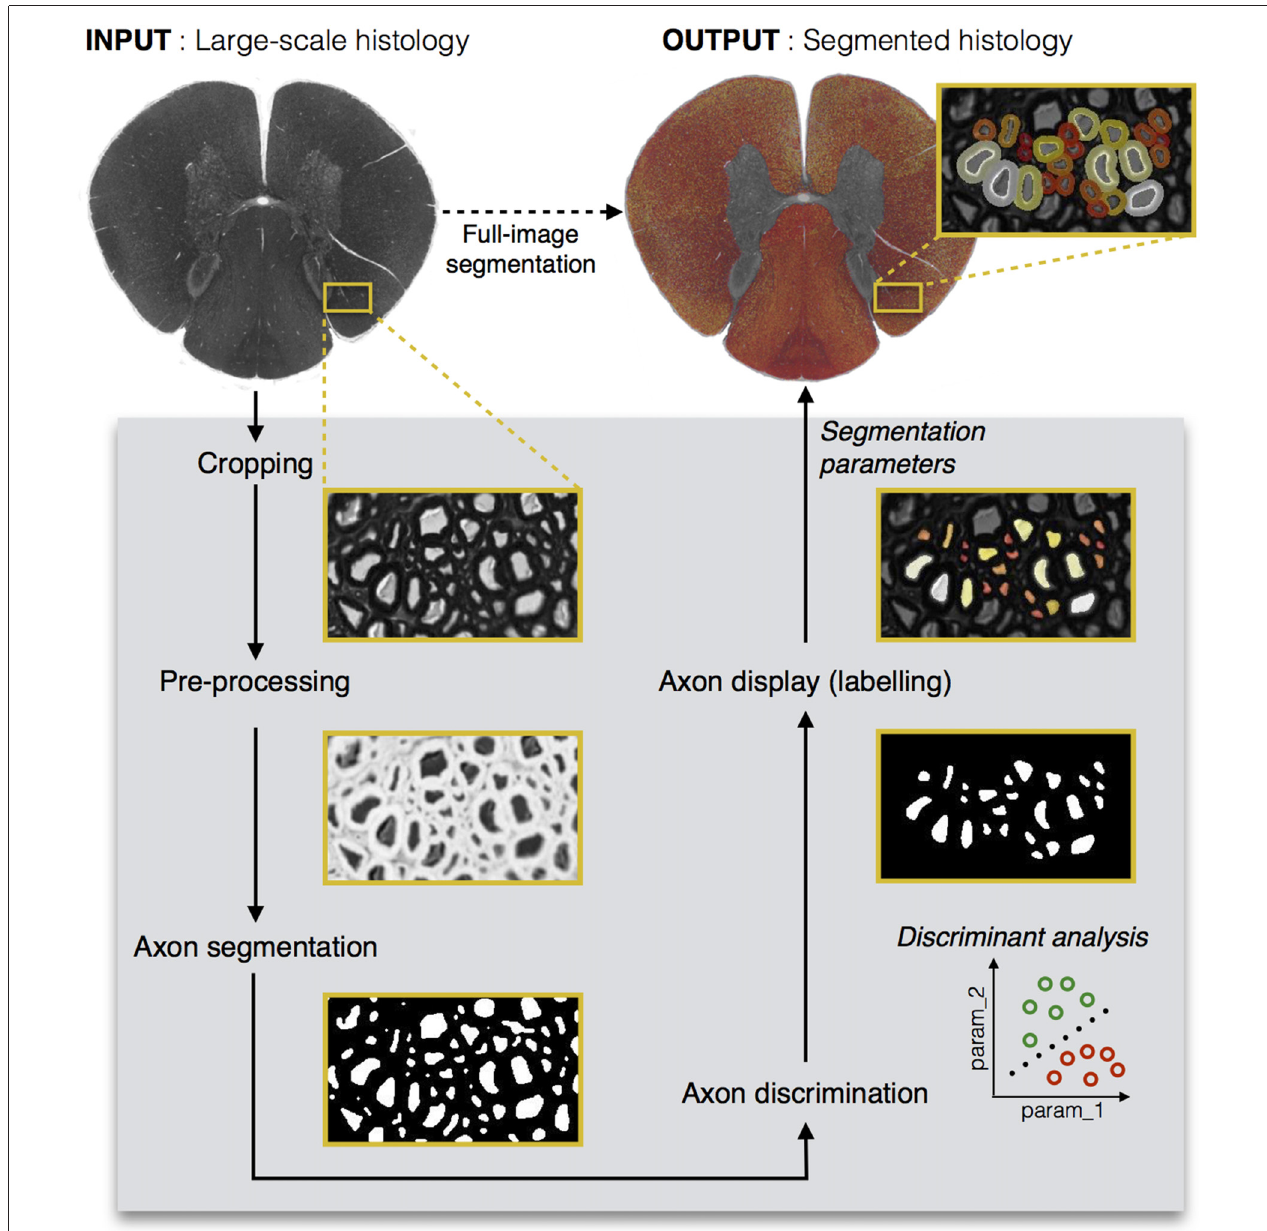
FIGURE 1 | Diagram illustrating the main steps of AxonSeg. Pre-processing, axon segmentation and discrimination are first performed on a cropped image. Then, the segmentation parameters applied on the cropped image are saved and can be used to launch the automatic full-scale segmentation of the axons and the corresponding myelin sheaths. Note that axons within a range of 2 µ m from the edge of the image are discarded to prevent the segmentation of incomplete